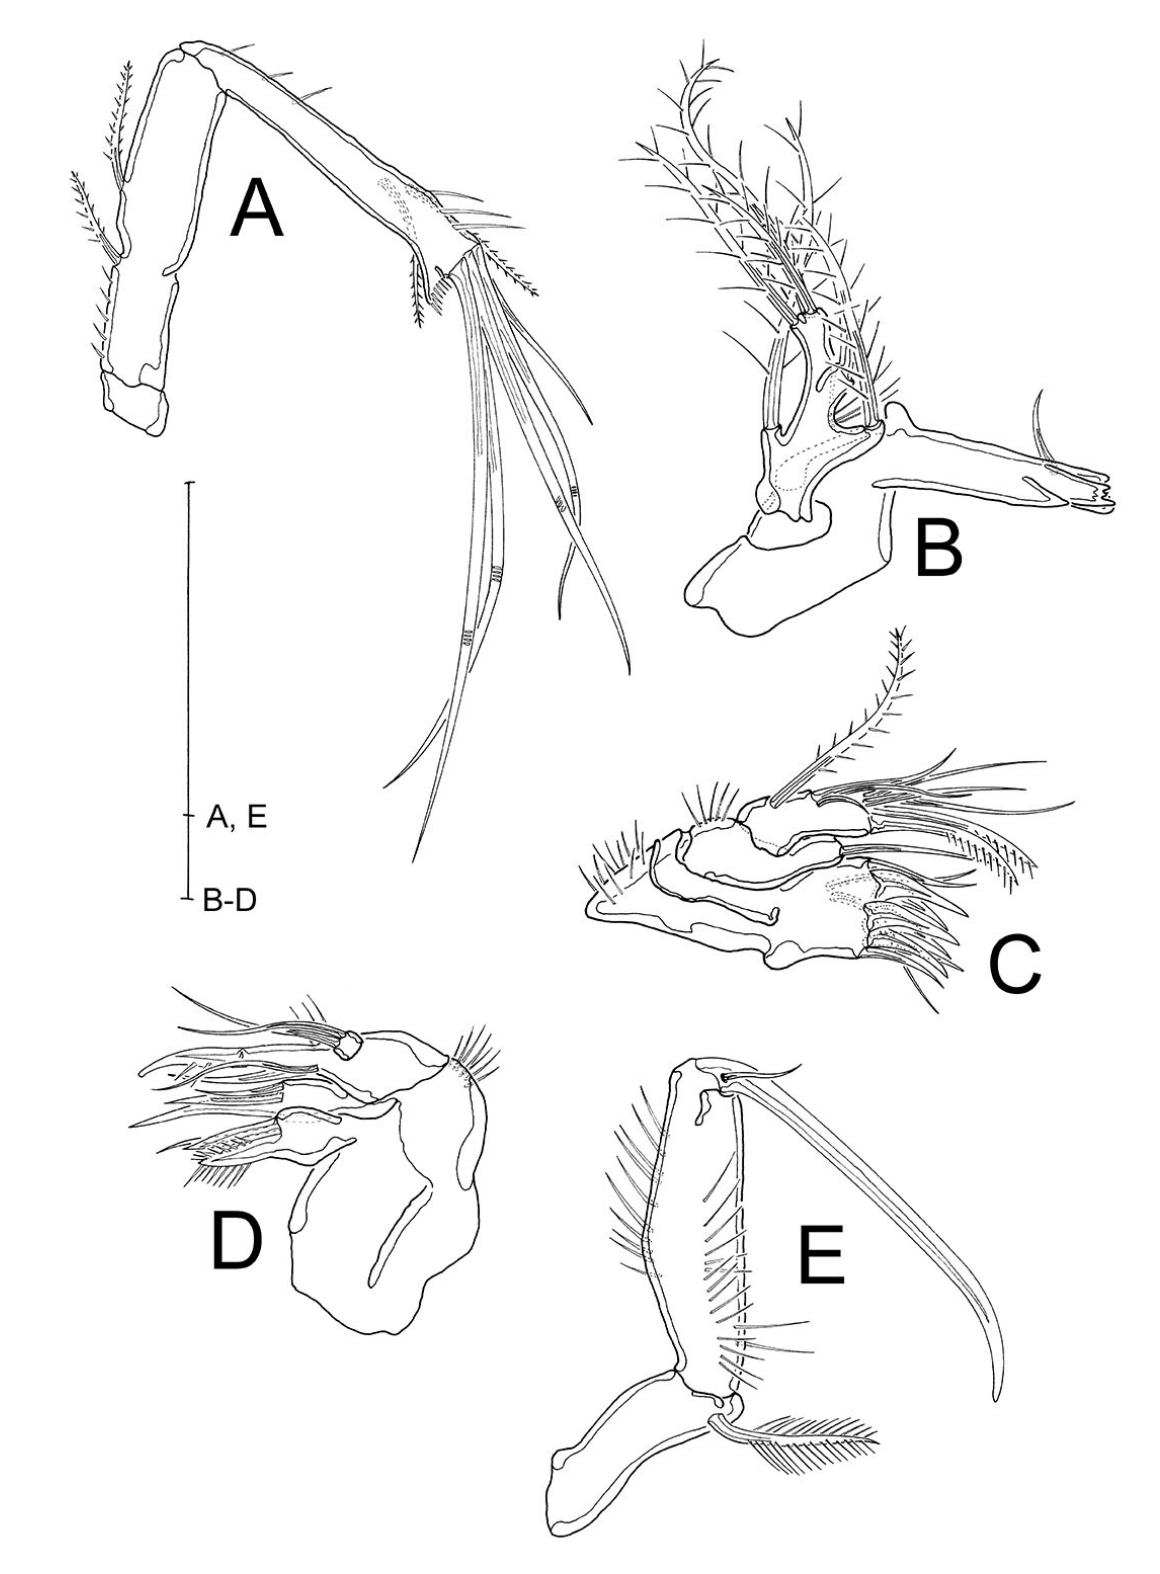
Fig. 11. Paratouphapleura aaroni gen. et sp. nov. A . Male paratype 4 (SMF 37274), A2. B–E . Female paratype 3 (SMF 37273). B . Md. C . Mxl. D . Mx. E . Mxp. Scale bars: 50